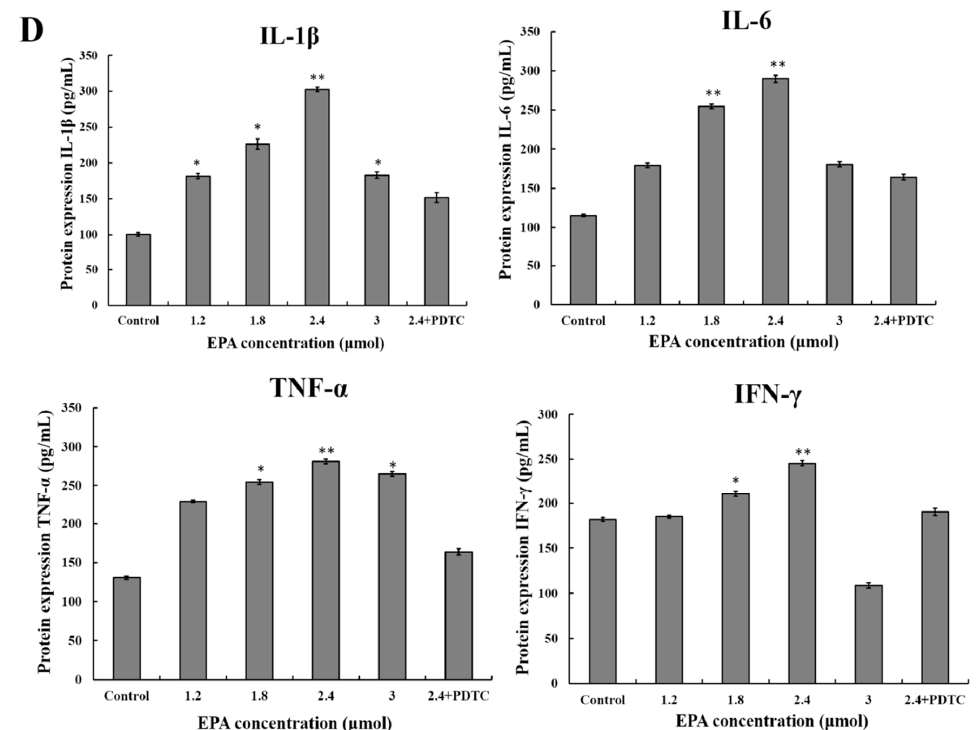
Figure 5. Effect of EPA on NF- κ B p65, iNOS and cytokines protein levels of in RAW264.7 cells. ( A ) Effect of EPA on the protein expression level of NF- κ B p65 and I κ B- α in RAW264.7 cells. The expression of protein was analyzed by Western blot. The β -actin was used as an equal loading control; ( B ) Immunofluorescence staining demonstrating the effects of DMSO (equivalent volume 3.0 μ mol EPA, as control) or EPA (3.0 μ mol) on subcellular localization of NF- κ B p65 in RAW264.7 cells. Visualization of the NF- κ B p65 fluorescence was recorded by using a LSCM, bar = 50 μ m (×400); ( C ) EPA regulated the protein expression of iNOS; ( D ) EPA regulated cytokines protein levels of RAW264.7 cells. Cells were treated with DMSO (equivalent volume 3.0 μ mol EPA, as control) or EPA at the various concentrations (1.2, 1.8, 2.4 and 3.0 µ mol) for 24 h in the presence or absence of pretreated 10 µ M PDTC. (Means ± SD, * p < 0.05 and ** p < 0.01 compared with the control). Each